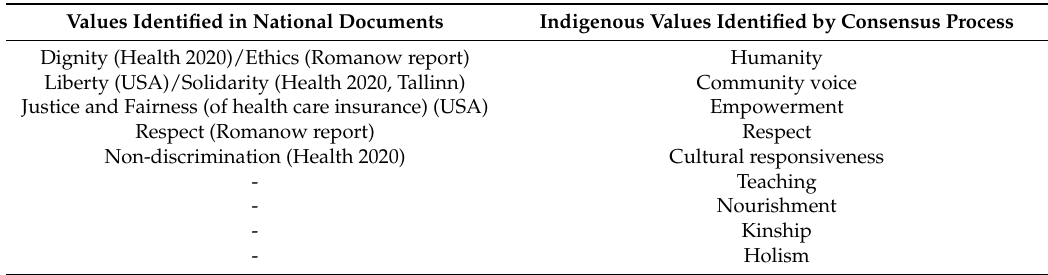
Table 2. Alignment of National and Indigenous